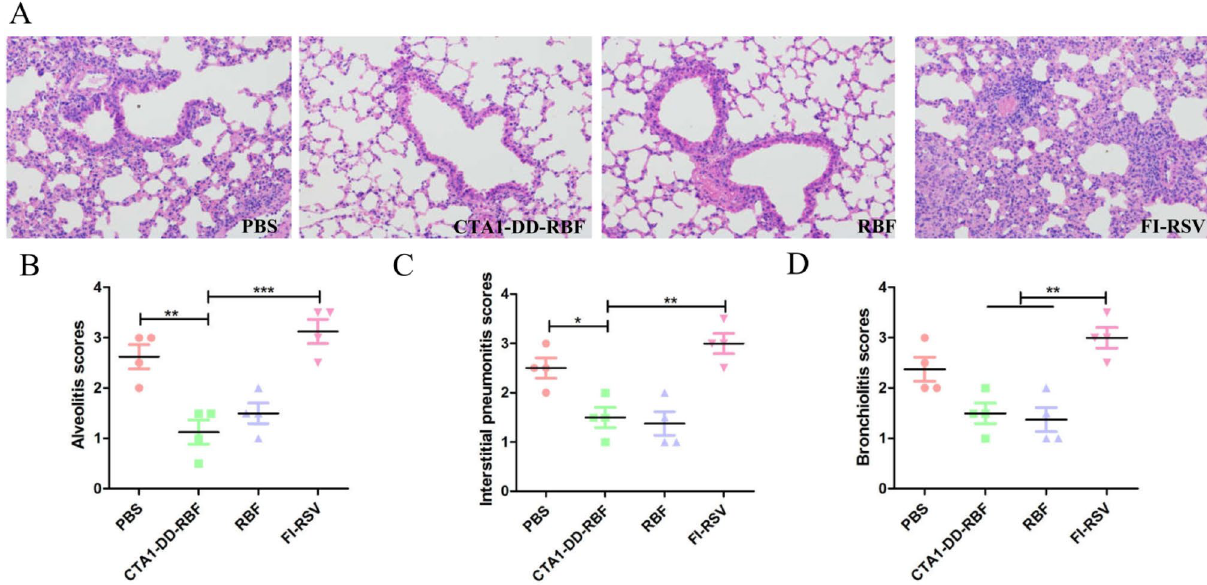
Figure 6. Histopathological analysis of hematoxylin and eosin (H&E)-stained lungs. The left lungs were dyed with H&E for histological assessment. All images were obtained at 200 × magnification. ( A ) The left lungs